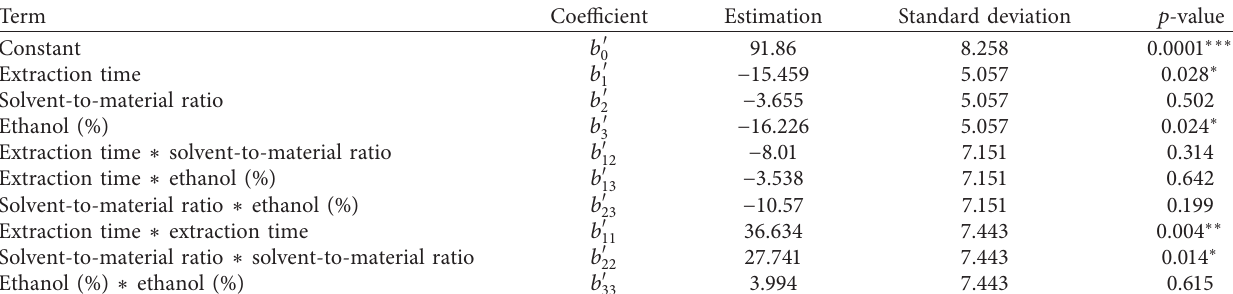
Table 5: Estimated regression coefficients for the response total polyphenol concentration and their level of significance p value.